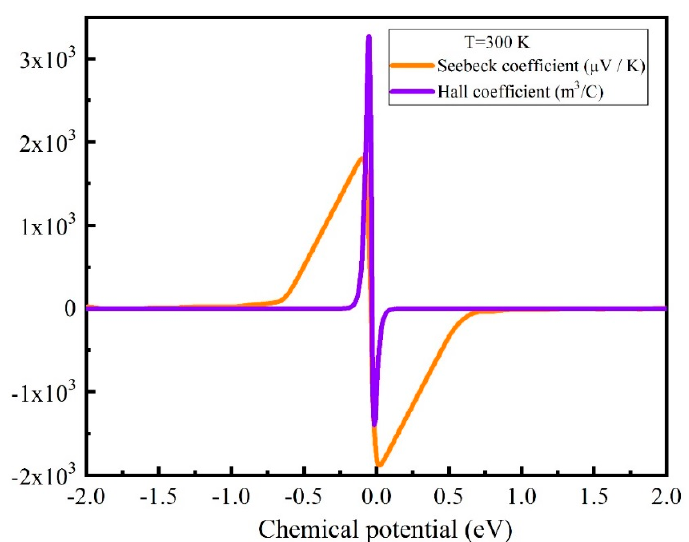
Figure 6. The Seebeck coefficient and the Hall coefficient versus the chemical potential at room tem- perature.